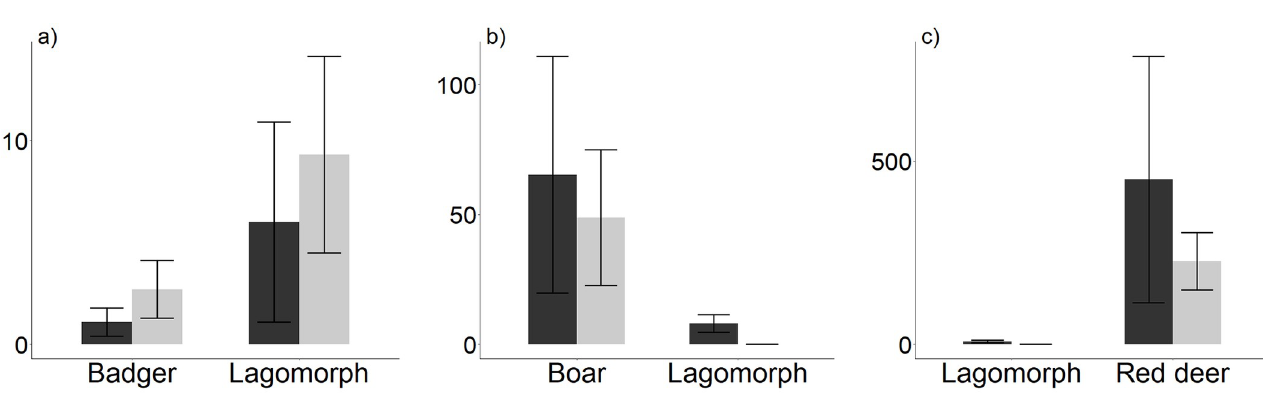
Fig 5. Difference in Pyrus bourgaeana visit patterns for frugivore pairs of species (null model 1). The observed values (black bars) represent the mean number of visits by a frugivore species (sp1) to individual plants visited (PV) by a second frugivore species (sp2). The expected values (grey bars) represent the mean number of visits by sp1 to plants not visited (PNV) by sp2. ( � P < 0.05, �� P < 0.01, ��� P < 0.001).